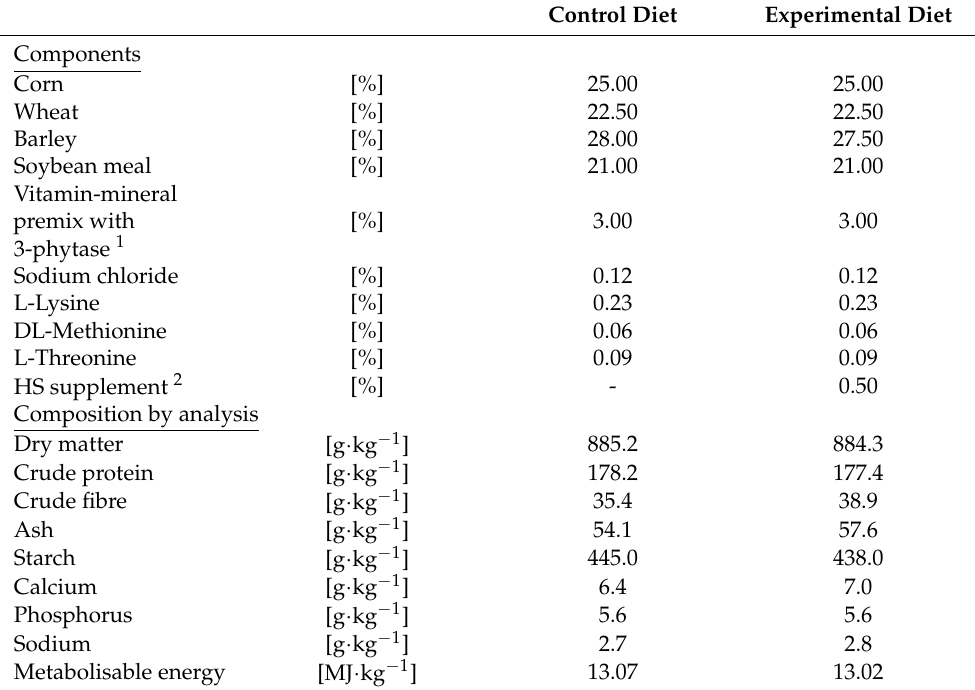
Table 1. Formula and chemical composition of feed mixtures for pigs (as-fed